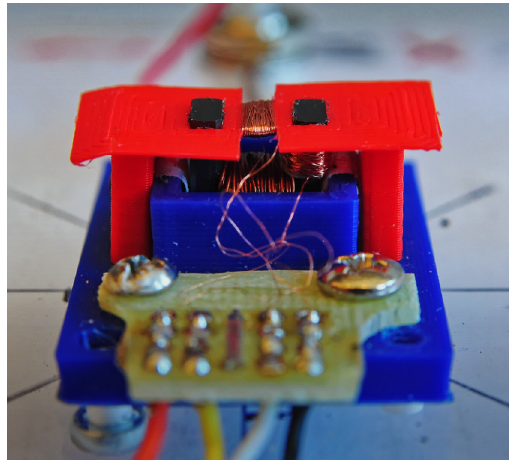
Figure 4. Photo of the transducer. Table 1. Transducer parameters.